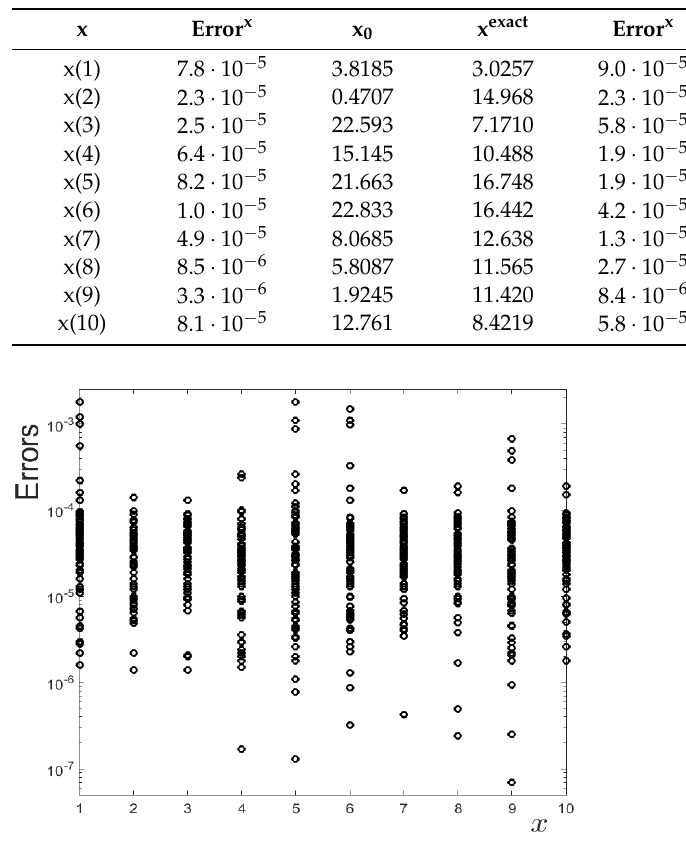
Table 10. Counterpart of Table 8 but allowing 30 (%) perturbations in the degradations. The exact values of T 4 t are 1391.6 K and 1490.9 K for the cases considered in columns 2–4 and 5–7, respectively, and are computed by the method with an error smaller than 0.1 K.